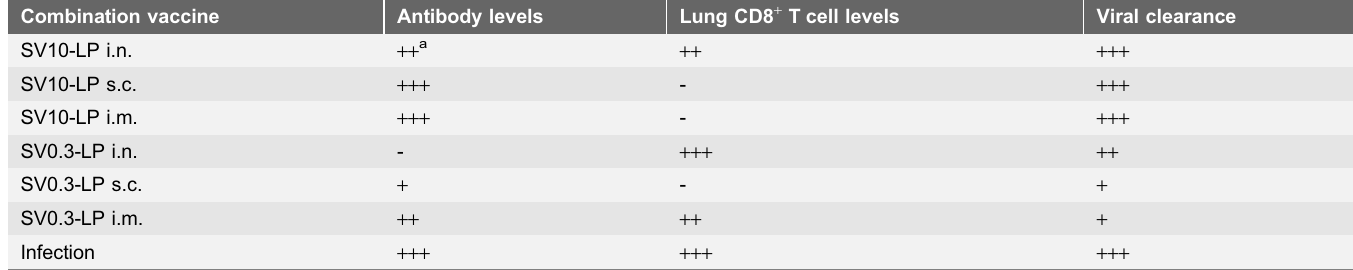
Table 1. Summary of immune responses induced by vaccination with combination